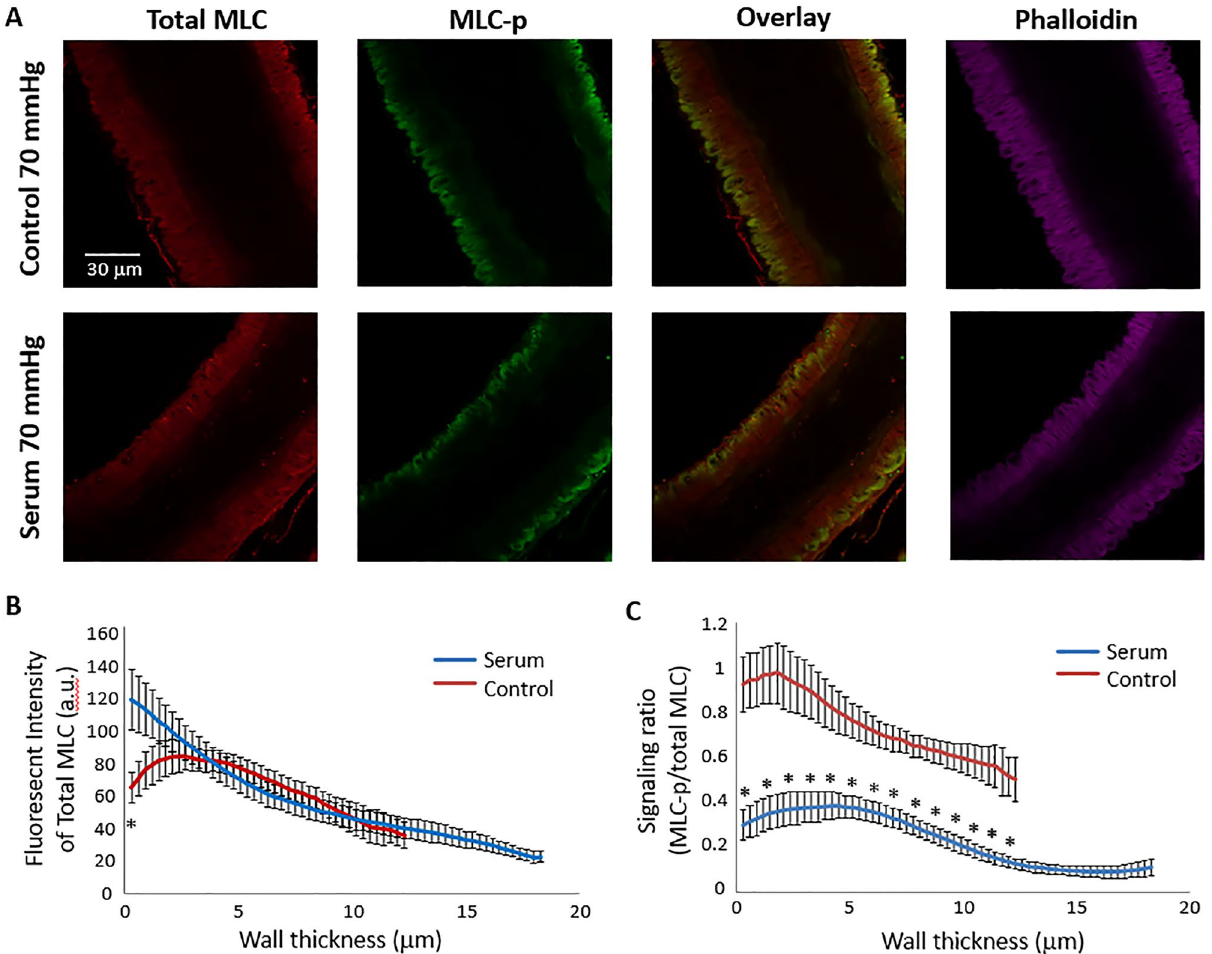
Figure 5. Comparison of total regulatory MLC and MLC-p labeling in control and serum constricted SCA. ( A ) Typical confocal fluorescence images of control and serum-treated rat SCAs immunolabeled for MLC-p, total regulatory MLC, and phalloidin-labeled actin filaments. ( B ) Comparison of total regulatory MLC fluorescent intensity in the vessel wall of control and serum treated rat SCAs. Mean ± SEM. ( C ) Comparison of MLC-p/ total MLC ratio in the smooth muscle layer of control and serum treated SCAs. Mean ± SEM. * p < 0.05 between control and serum treated vessels. N = 6 vessels for control and serum treated groups